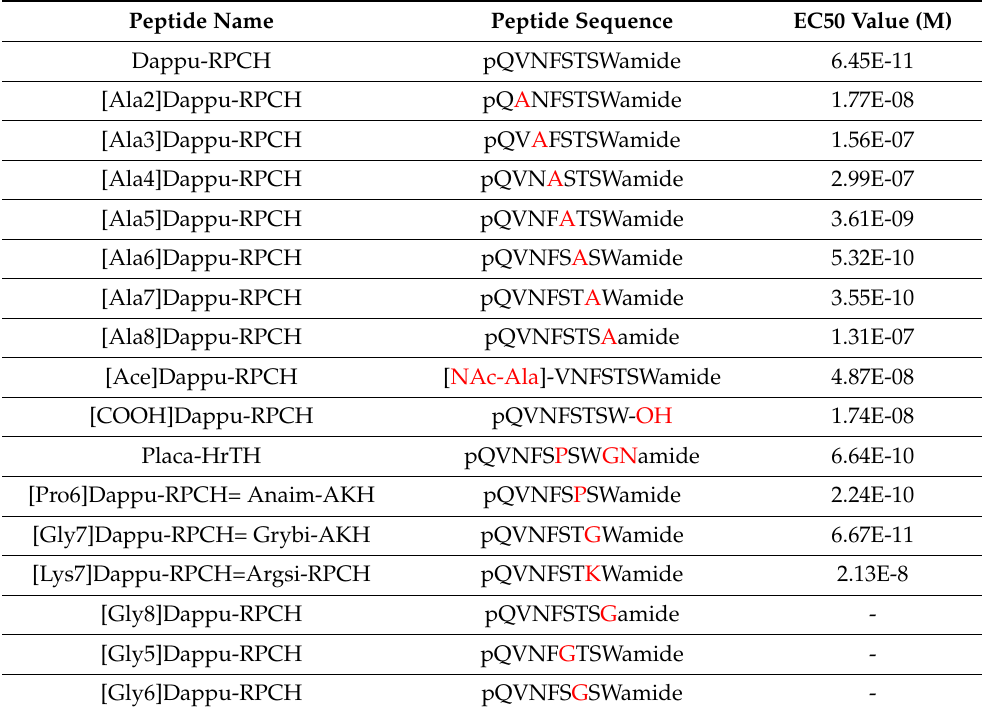
Table 1. Analogues of Dappu-RPCH together with their EC 50 values tested on the Daphnia pulex RPCH receptor according to [13]. Mutated residues are shown in